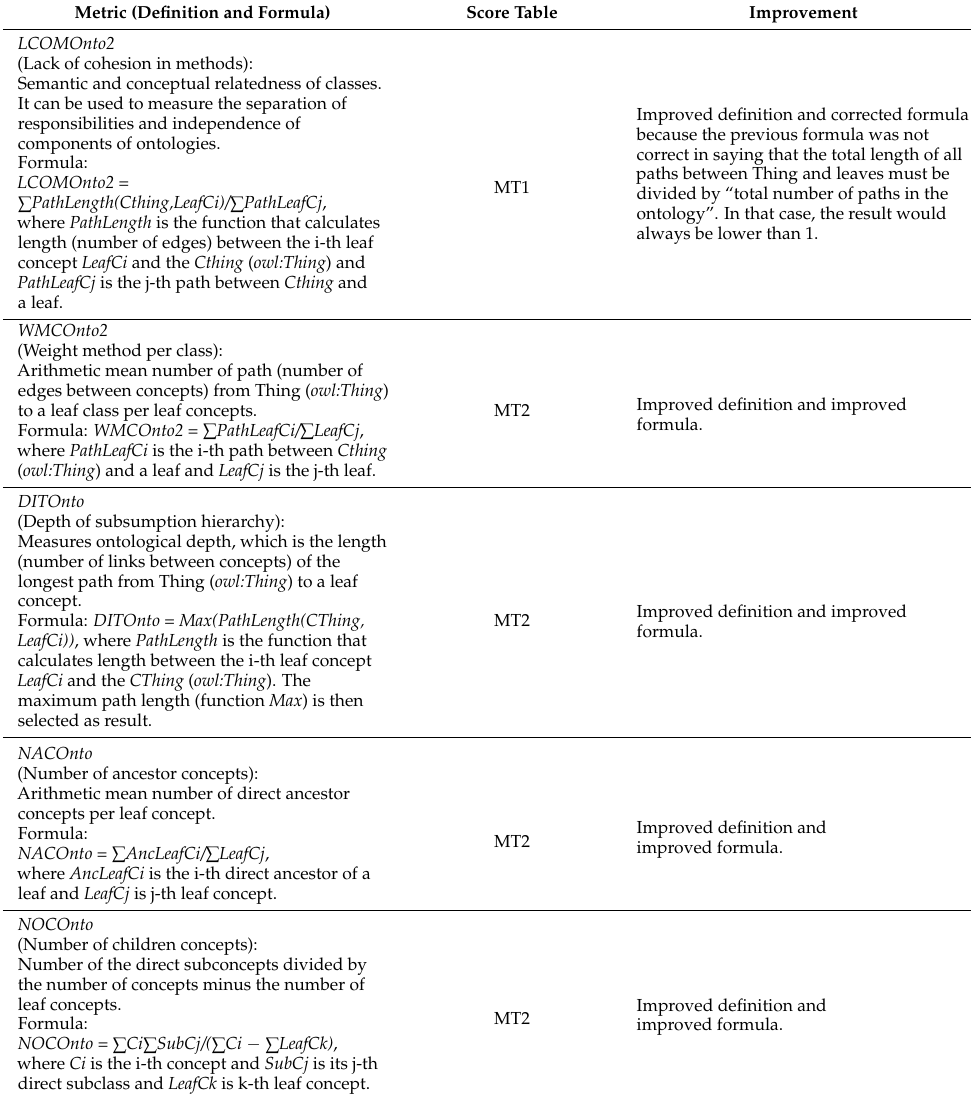
Table 2. Complex ontology metrics obtained from the improved OQuaRE